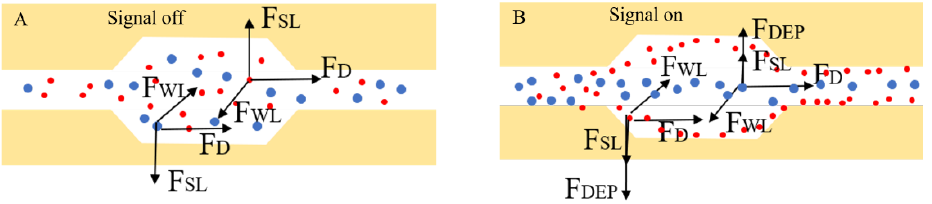
Figure 6. ( A ) The mechanical analysis when no signal was added (inertial sorting); ( B ) the mechanical analysis when the signal was applied (coupled with inertial force and DEP force).